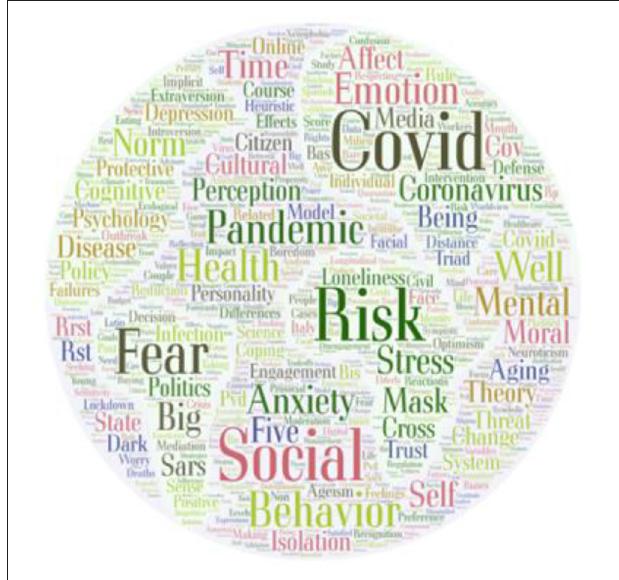
FIGURE 1 | The word cloud derived from the key words of the published articles in this Research